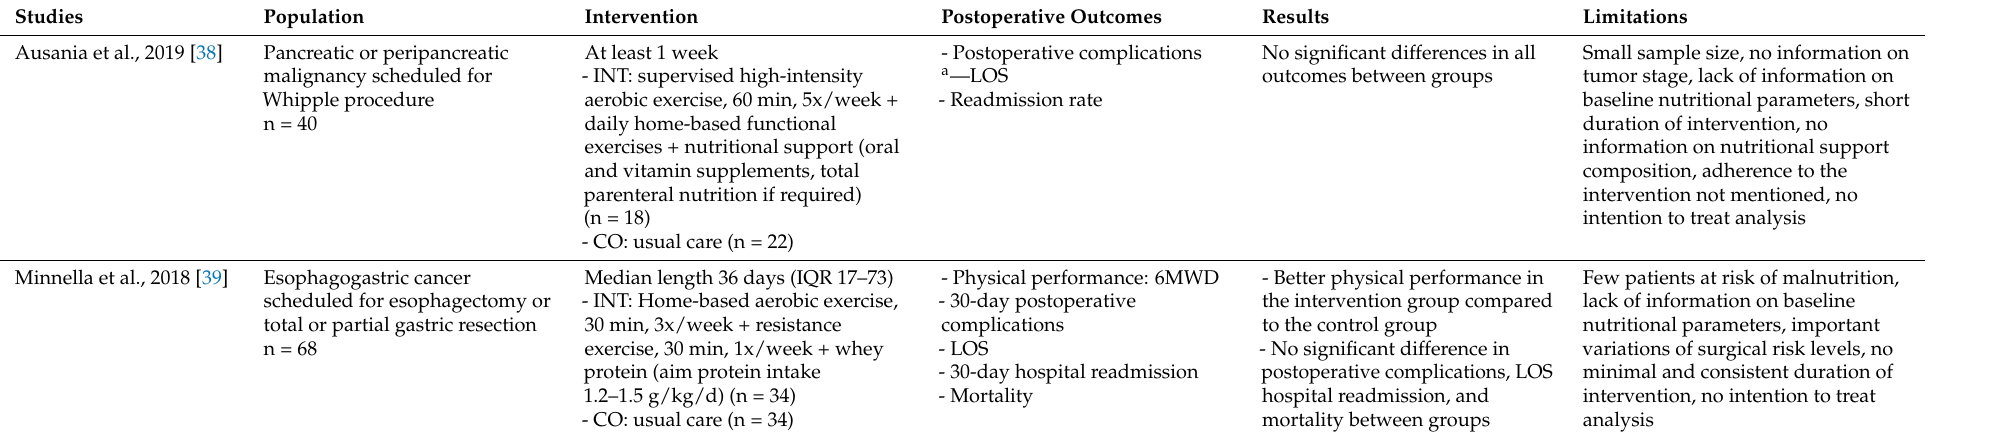
Table 4. Combined nutritional and physical activity interventions before surgery in patients with gastrointestinal